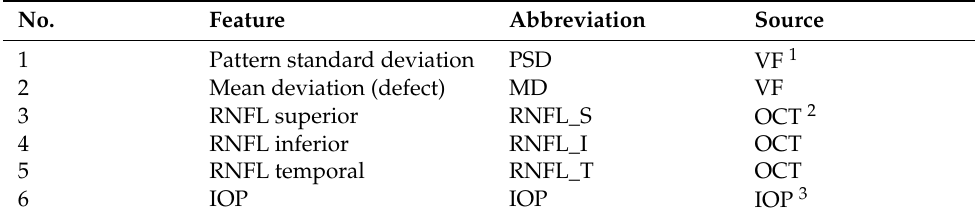
Table 3. List of selected features.